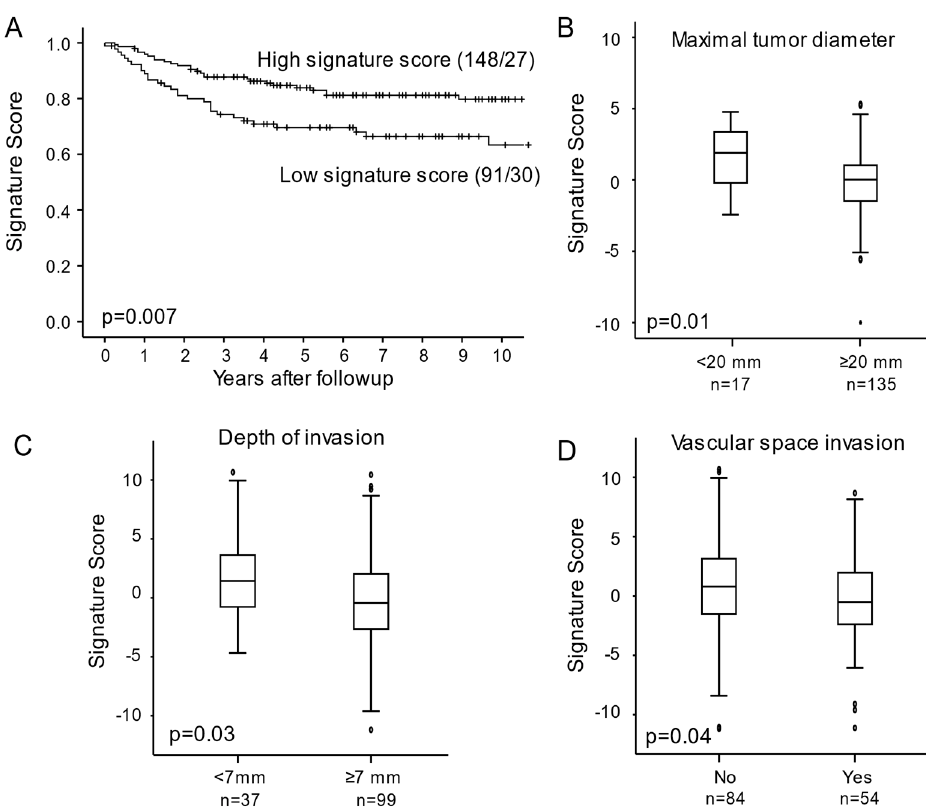
Figure 3. ( A ) Disease-specific survival for cervical cancer patients relative to signature score repre- sented by Kaplan-Meier curve with probability values for Mantel-Cox log-rank test that compares categories. The number of patients and events are given within parentheses (patients/events). Sig- nature score in relation to MRI derived maximal tumors diameter ( B ) histopathological depth of invasion ( C ) and, vascular space invasion ( D ) in tumors with available data.